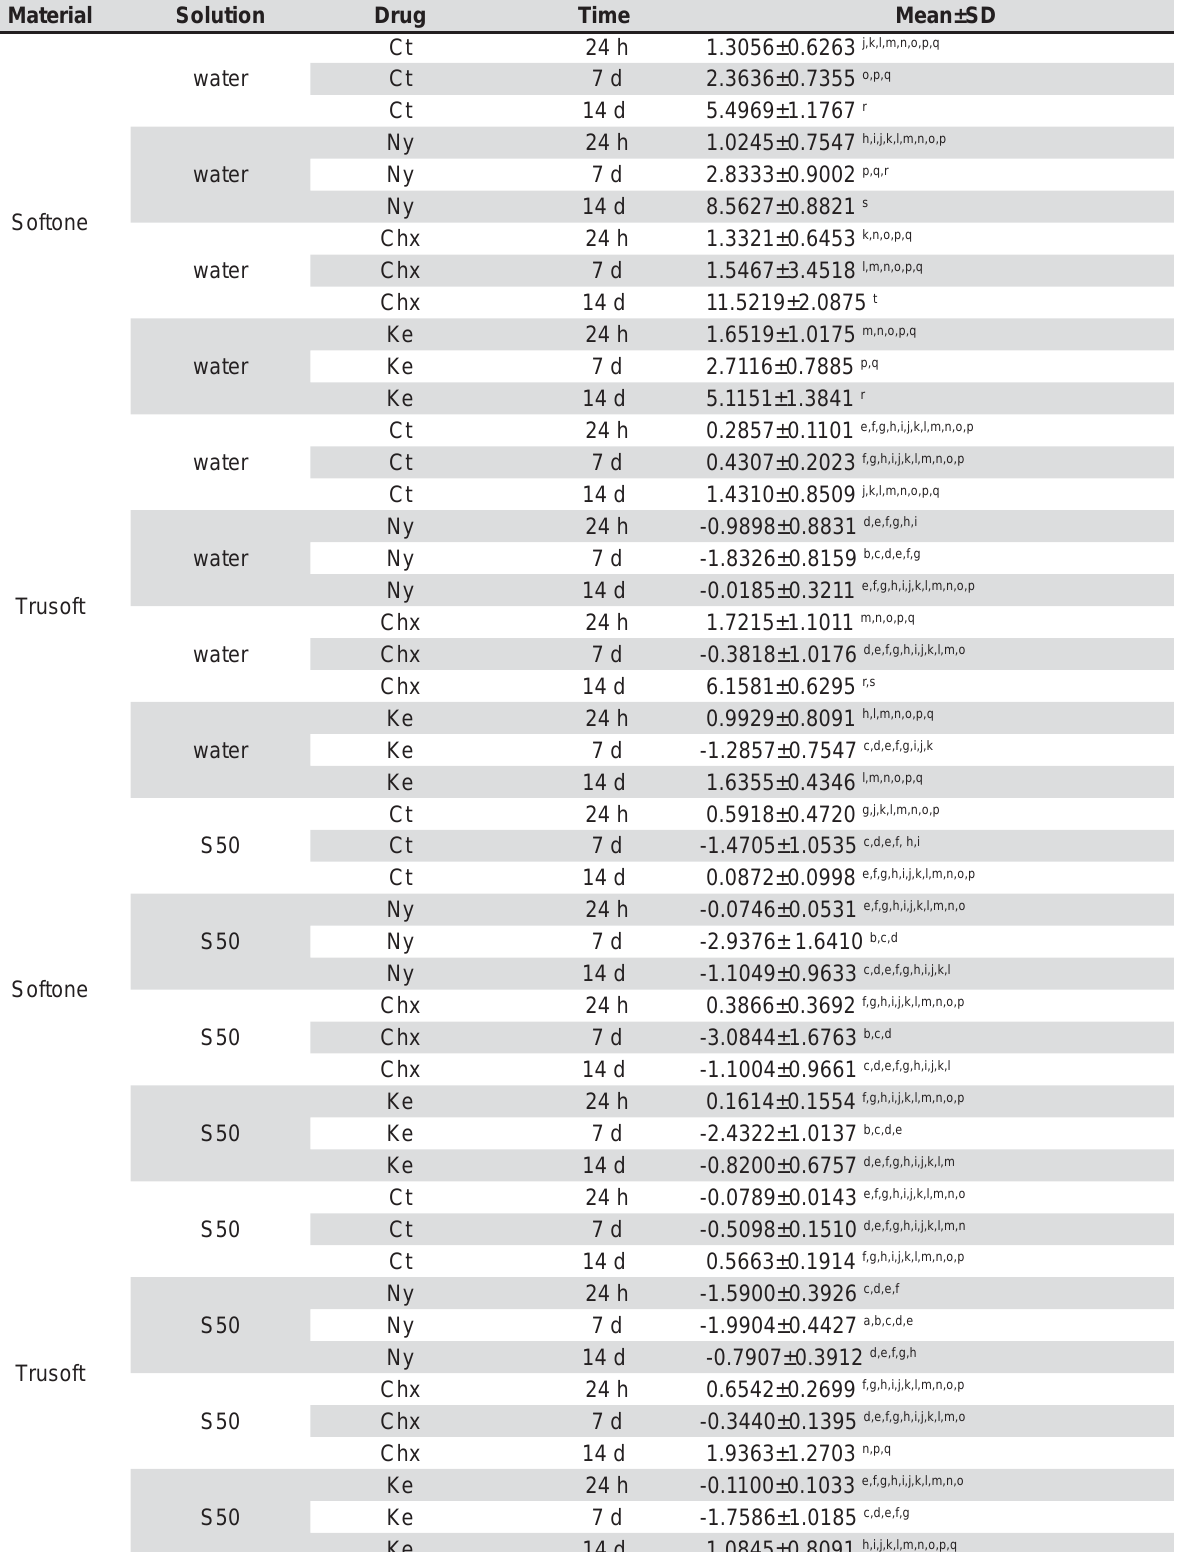
Porosity of temporary denture soft liners containing antifungal Table 1- Porosity factor means (%) ± standard deviations for the experimental conditions